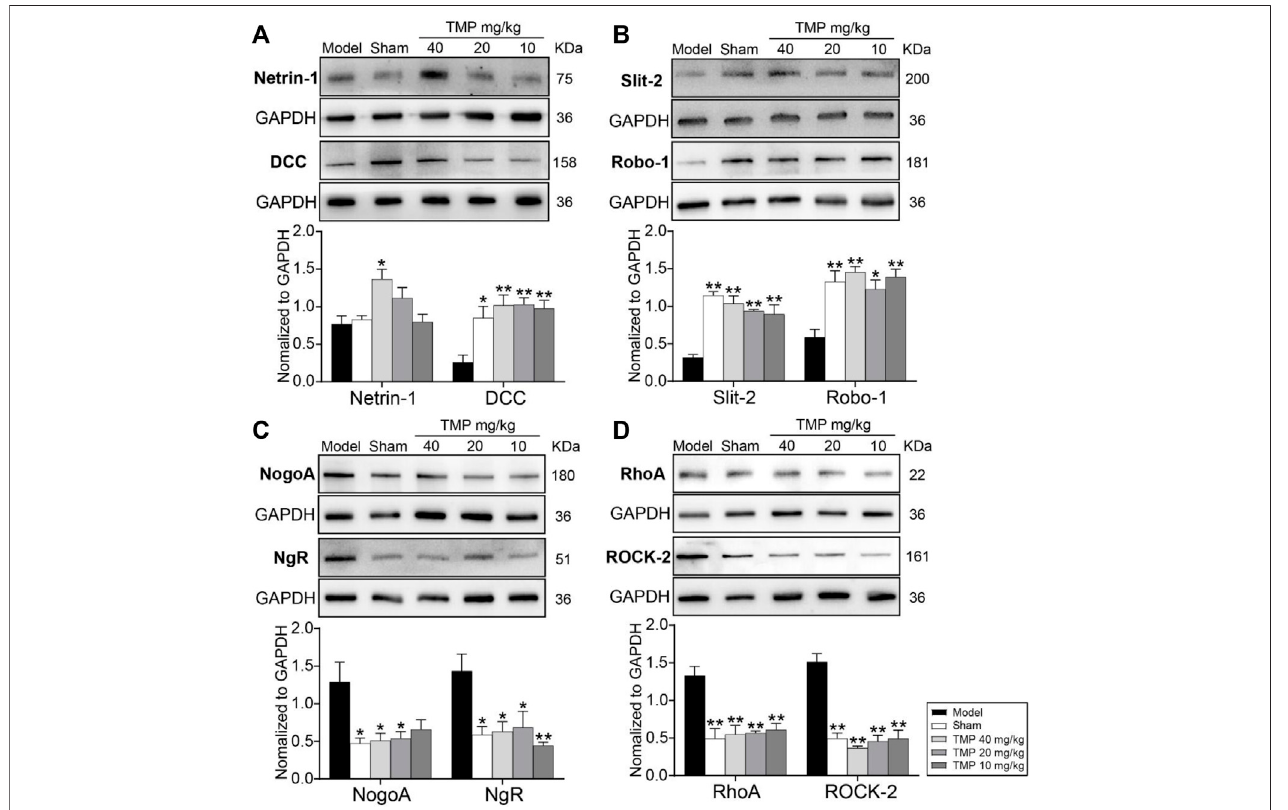
FIGURE 7 | Effects of TMP on the expressions of axonal guidance and growth-inhibitory signals in MCAO rats. Typical Western blot images and analysis for (A) Netrin-1/DCC, (B) Slit-2/Robo-1, (C) NogoA/NgR, and (D) RhoA/ROCK-2 ( n = 4). The protein levels were quanti fi ed with GAPDH as the loading control. * p < 0.05 and ** p < 0.01 vs. Model